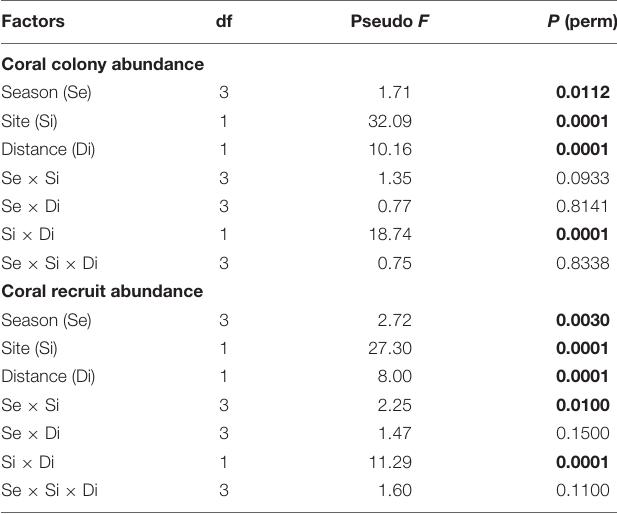
of the observed variation. Differences between distance zones were mostly attributed to M. alcicornis (7.31%), P. porites (5.82%), P. astreoides (5.44%), and O. annularis (4.92%), with a total